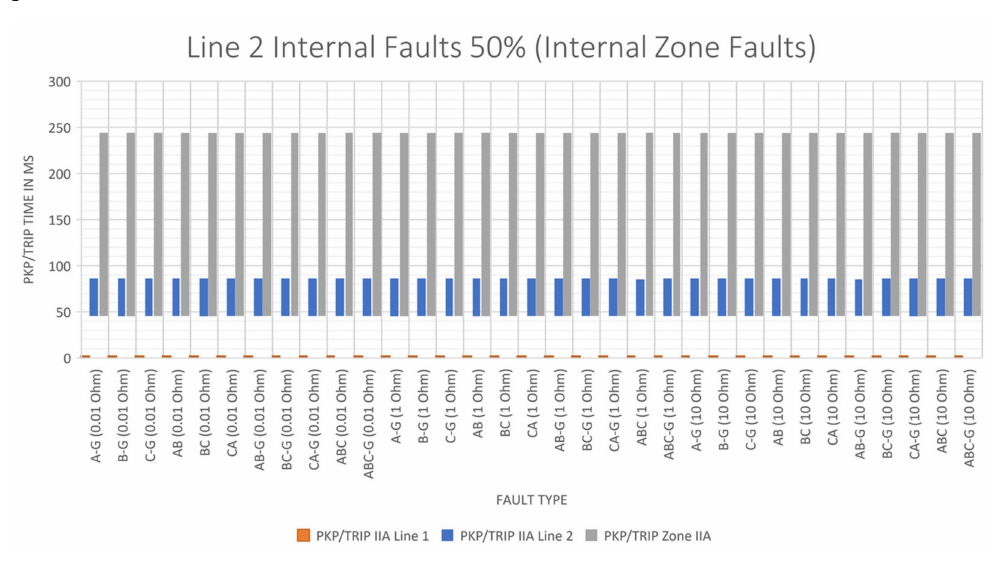
Figure 24. Internal line faults in Line 2 (50%); four